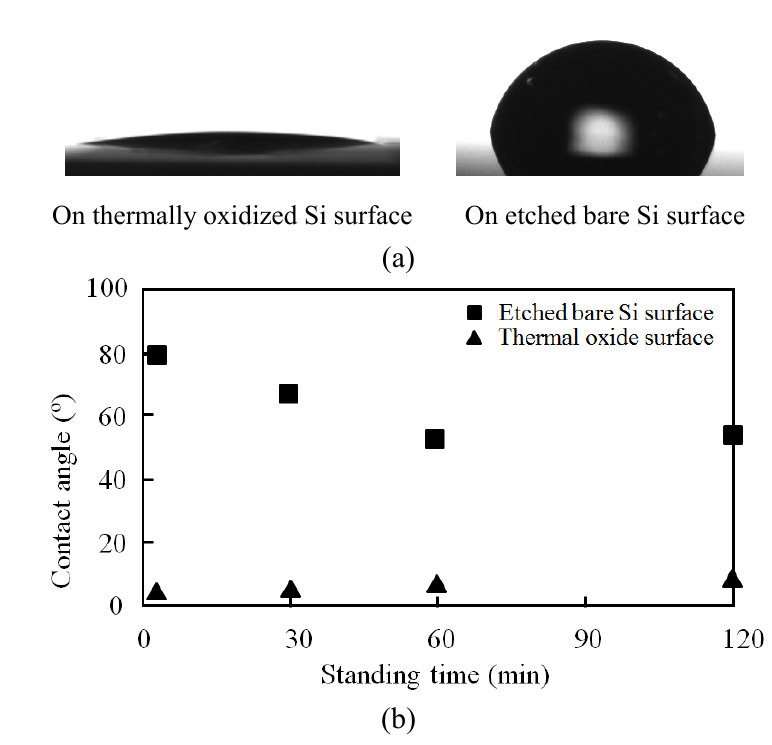
Figure 4. (a) Contact angle on thermal oxide surface (left) and on etched Si surface (right) and (b) time course of water contact angle on the oxide surface and the bare Si